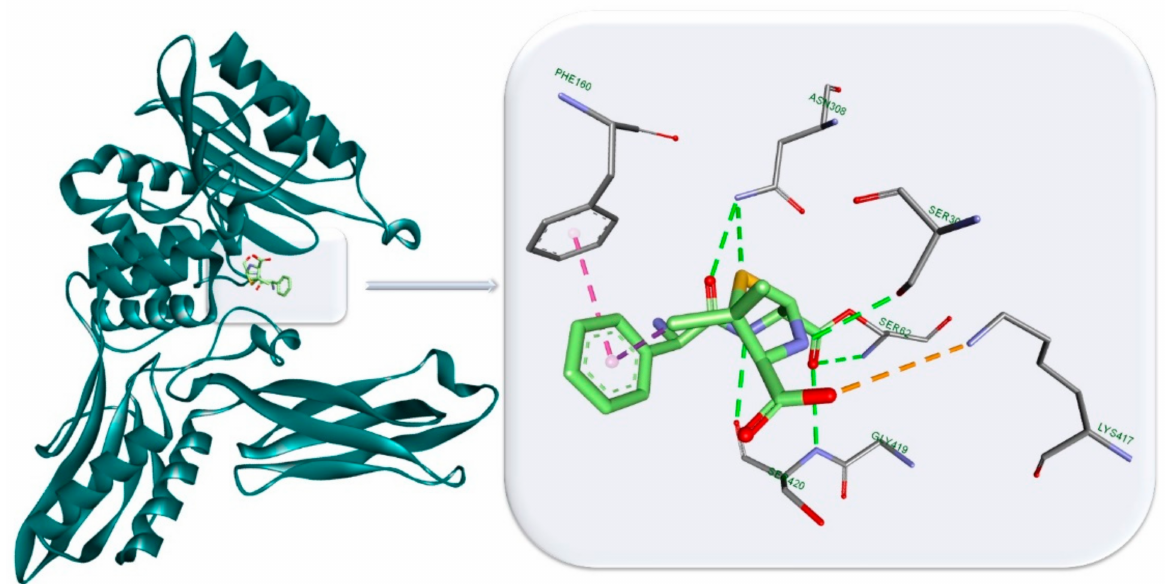
Figure 3. Penicillin binding protein 4 (PBP4) from E. coli in complex with ampicillin (light green): HBs (Ser 30, Ser 62, Ser 420 and Asn 308) are depicted as green dotted lines, Pi-hydrophobic interactions (Phe 160) are depicted as purple dotted lines and electrostatic interactions (Lys 417) as orange dotted lines. The figure was built with Biovia Discovery Studio 4.1 using the PDB entry 2EX6